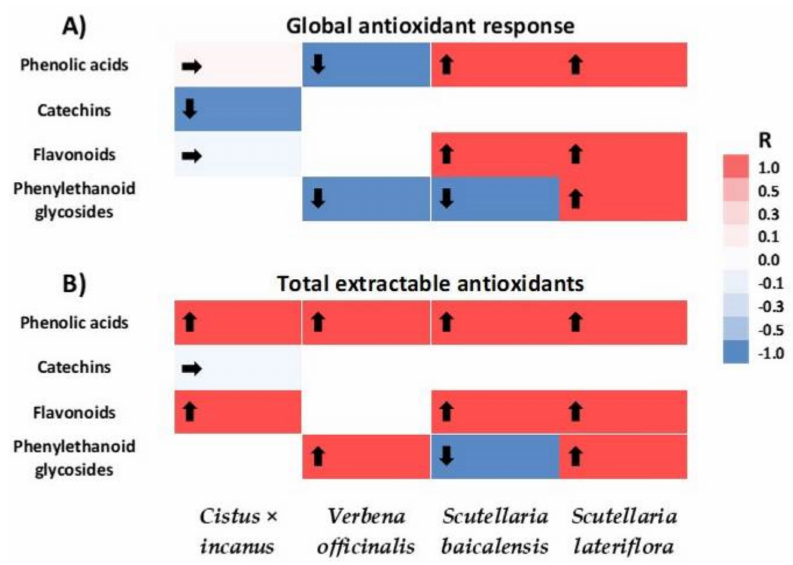
Figure 1. Heat map of correlation between phenolic acids, catechins, flavonoids, and phenylethanoid glycosides and antioxidant potential in biomasses cultured in vitro and in soil-grown plant raw mate- rials of Cistus × incanus , Verbena officinalis, and Scutellaria baicalensis, and Scutellaria lateriflora . Global antioxidant response panel ( A ), and total extractable antioxidants panel ( B ). Color saturation represents the intensity, whereas arrows represent the direction of correlation coefficient value (R)